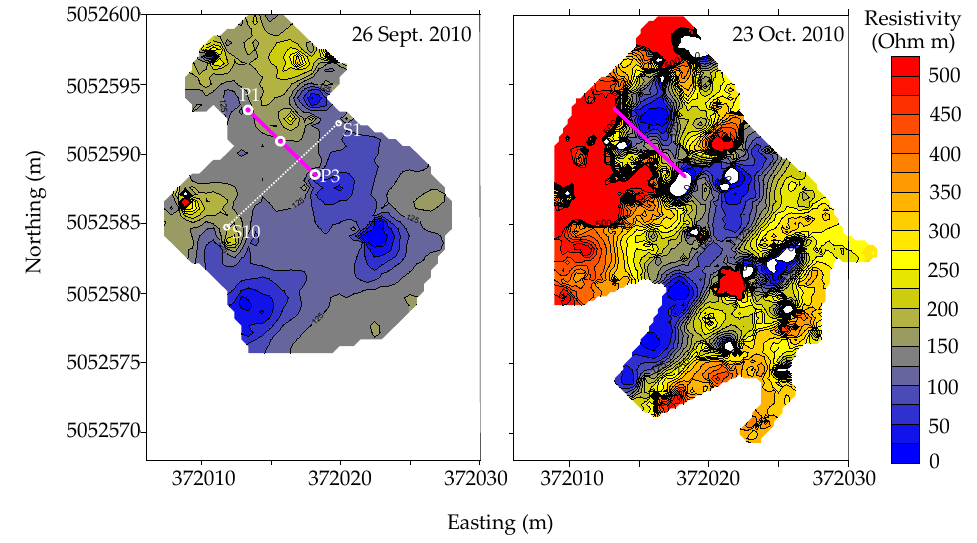
Figure 15. Cogne site, 2010. EMI maps, shown as electrical resistivity values. The strong change between 26 September (more conductive) and 23 ctober (more resistive) is remarkable. The maps represent the mean electrical resistivity from the ground surface to a depth estimated around 1.5 m. The purple line shows the location of the ERT line (results in Figure 16). The white dots represent the two TDR transects: P indicates the progressive 0.75 m depth measurements; S indicates the progressive 0.15 and 0.30 m depth measurements.